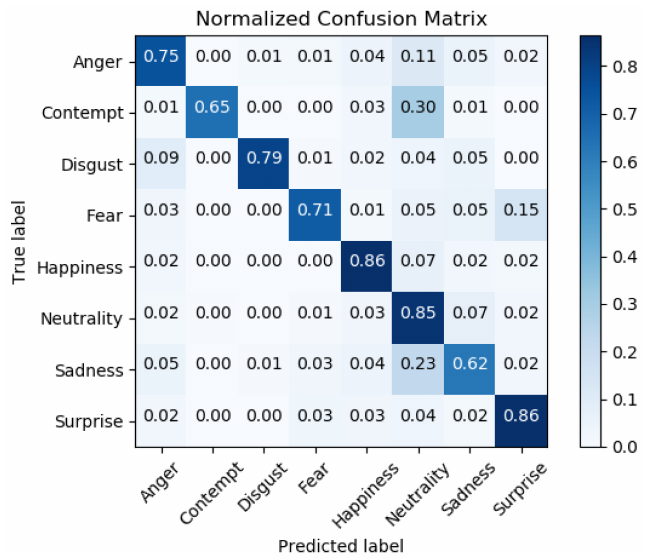
Figure 1. Normalized confusion matrix of the neural network described in [25], trained by using the “Ensemble 1” dataset